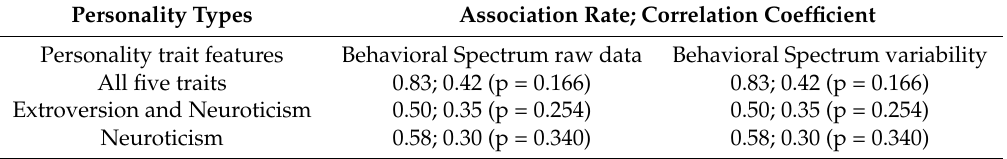
Table 5. Association between personality traits and user activity trials in HS data obtained during the afternoon period.